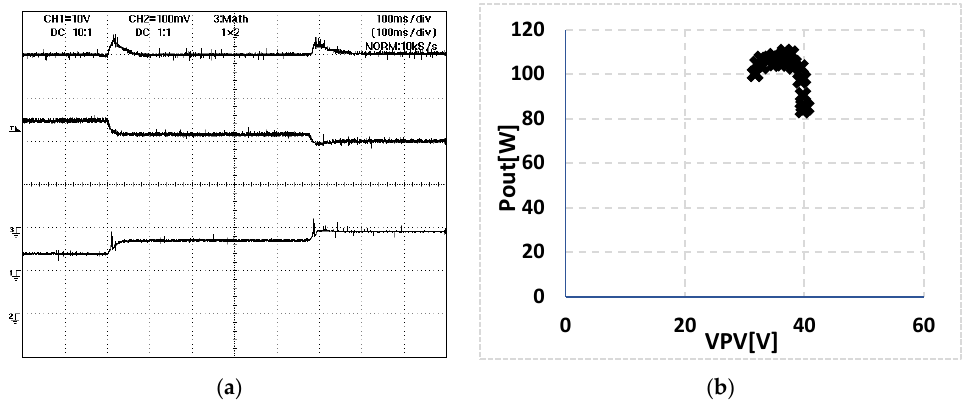
Figure 15. Experimental result in mode II ( MPPT test mode): ( a ) output power (Ch3), output voltage (Ch1 – 50/div) and output current (Ch2 – 1A/div) of the boost converter considering two-step load variations; ( b ) multiple data points achieved during the operation of the P&O MPPT algorithm.